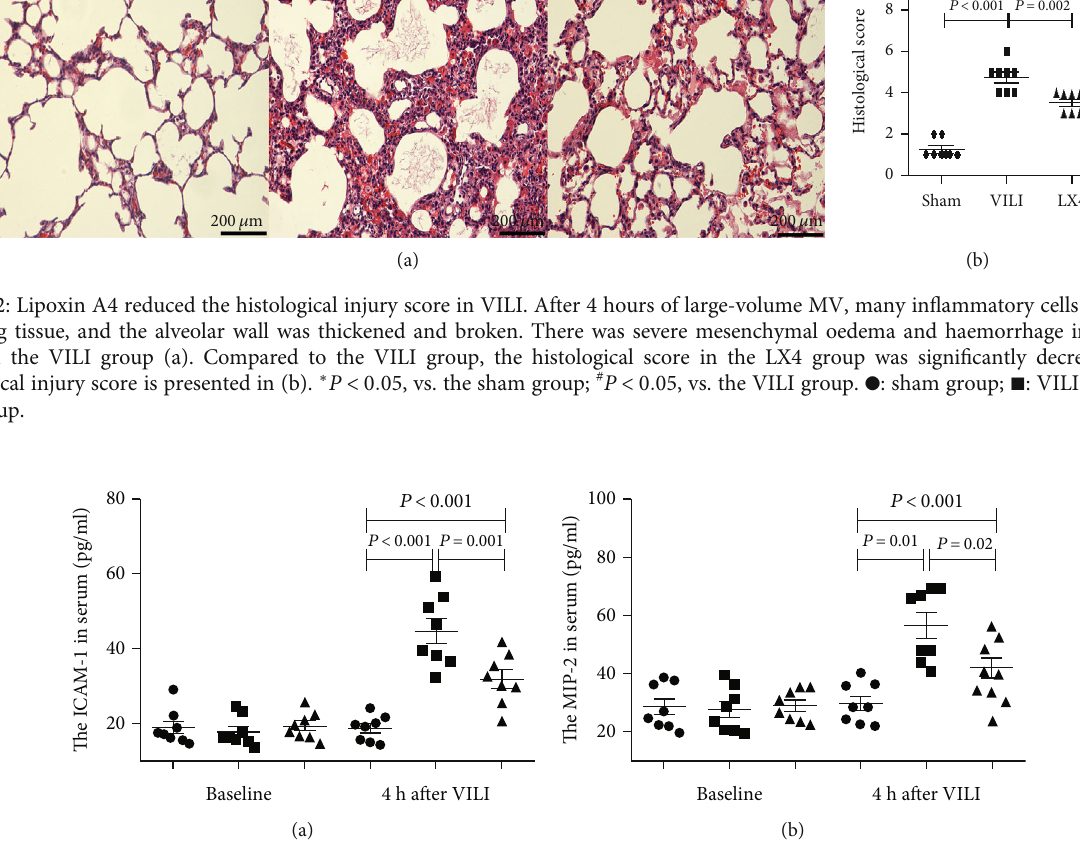
Figure 3: Lipoxin A4 reduced systemic in fl ammation in VILI. After MV, the levels of ICAM-1 and MIP-2 in serum were signi fi cantly increased in the VILI and LX4 groups. However, lipoxin A4 notably reduced the increase in ICAM-1 and MIP-2 levels in serum. ∗ P < 0 : 05 , vs. the sham group; # P < 0 : 05 , vs. the VILI group. ● : sham group; ■ : VILI group; ▲ : LX4